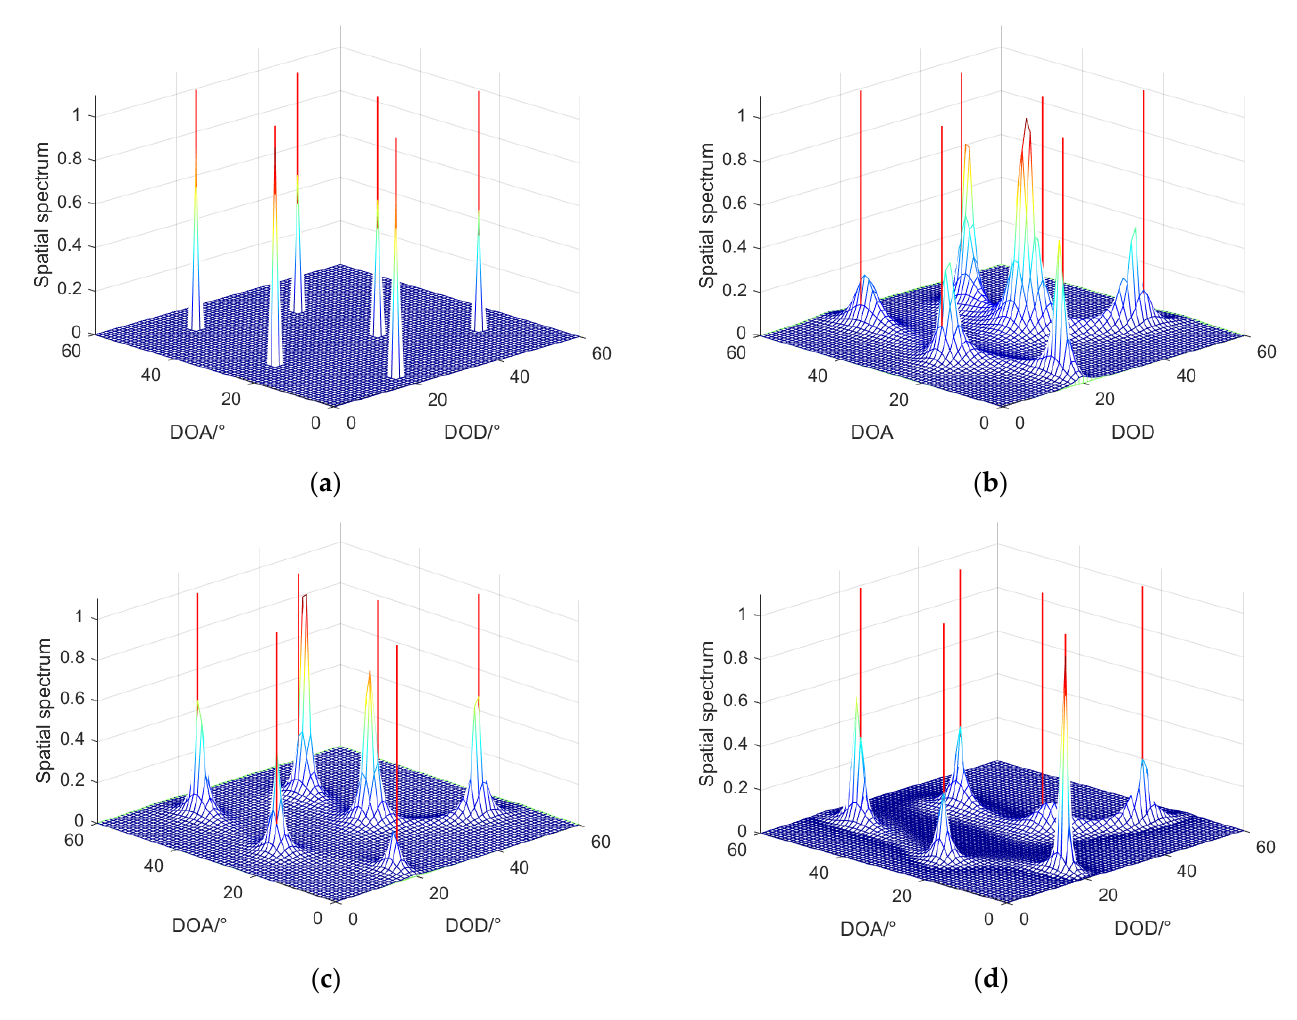
Figure 4. Results of the spatial spectral estimation of different algorithms: ( a ) LMR algorithm; ( b ) SMS algorithm; ( c ) ASDS algorithm; ( d ) TRDS algorithm.